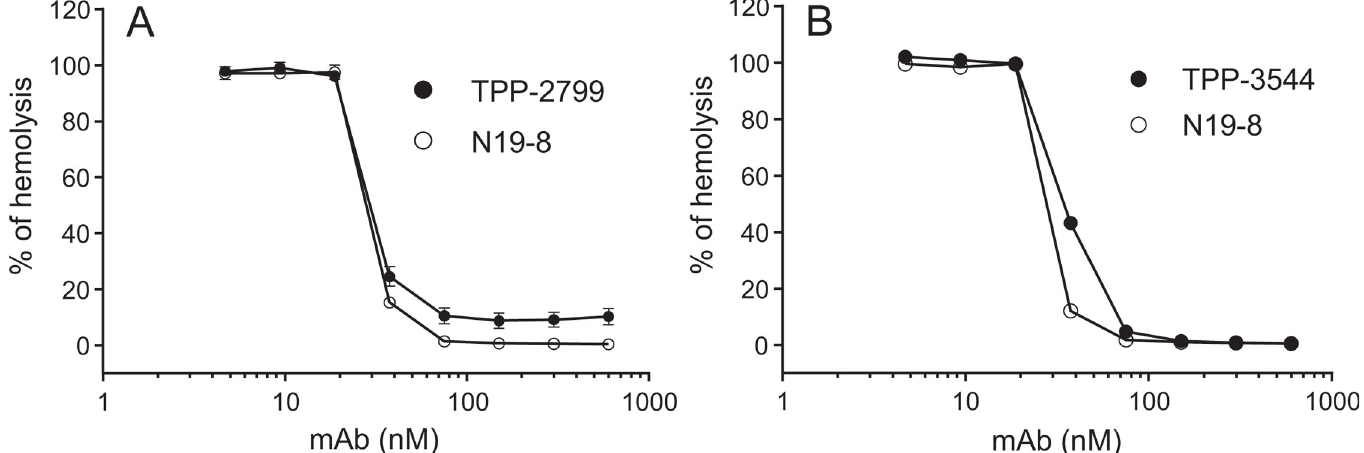
Fig 1. Recombinant anti-C5 mAbs TPP-2799 and TPP-3544 inhibit classical-pathway hemolysis. Anti-C5 mAbs TPP-2799 (closed circles in panel A) and TPP-3544 (closed circles in panel B) showed potent and dose-dependent inhibition of classical-pathway hemolysis, similarly to the C5-binding mAb N19-8 control (open circles in panels A and B). Abbreviations: C5 = complement component 5; mAb = monoclonal